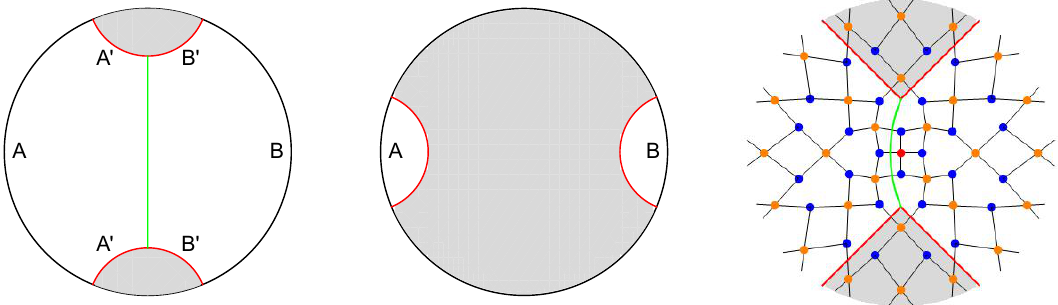
Figure 2. Left: for su(cid:14)ciently large A and B , the entanglement wedge is connected (the RT surface (cid:6) is shown in red) and the E p is computed by the length of the green geodesic X . Center: for small A and B , the entanglement wedge is disconnected and the E p is zero. Right: tensors under a causal cut in MERA (red line) can be gotten rid of by a unitary transformation. In each case, the region to be cut out is shaded in